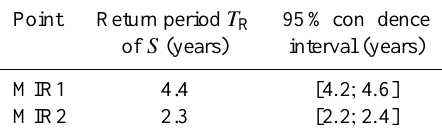
Table 1. Return period of S (combinations that lead to exceedance of R C ) and 95% confidence interval for both study points.